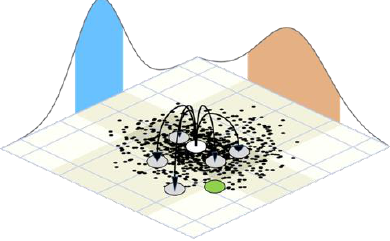
Figure 2. Representation of the variational method, where each sample embedding (white circle) is probabilistically placed (grey circles) at a nearby position (green circle).